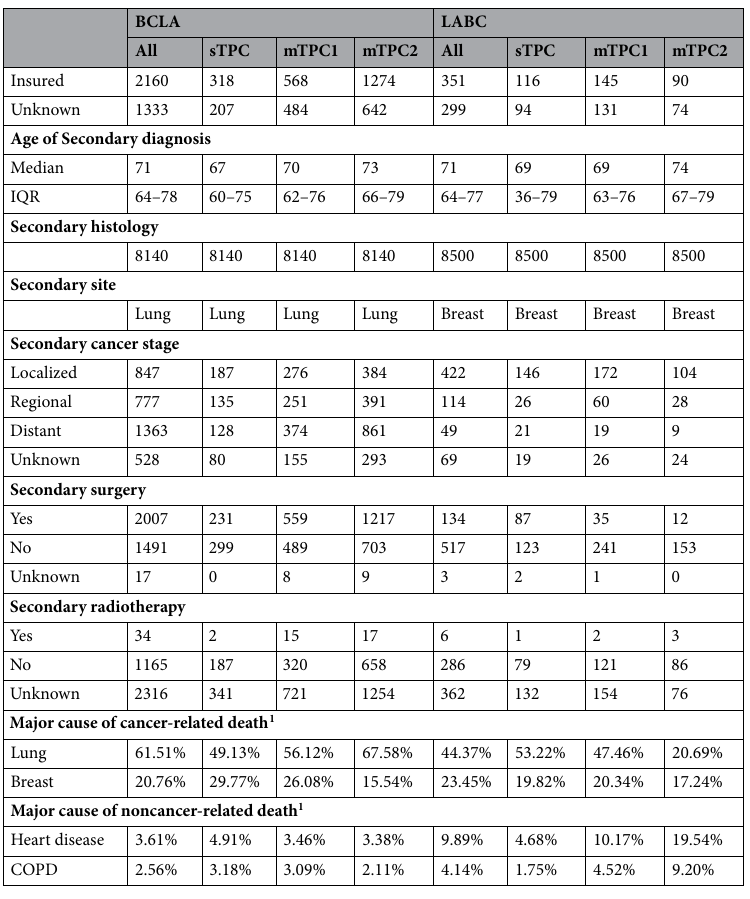
Table 1. Summary of identified two primary cancer patients. NHW Non-Hispanic White, NHB Non-Hispanic Black, NHA Non-Hispanic Asian or Pacific Islander, 8500: duct carcinoma, 8140: Adenocarcinoma. Major cancer-related death 1 : percent of cancer-related death in total death; Major noncancer-related death 1 : percent of noncancer-related death in total death. COPD chronic obstructive pulmonary